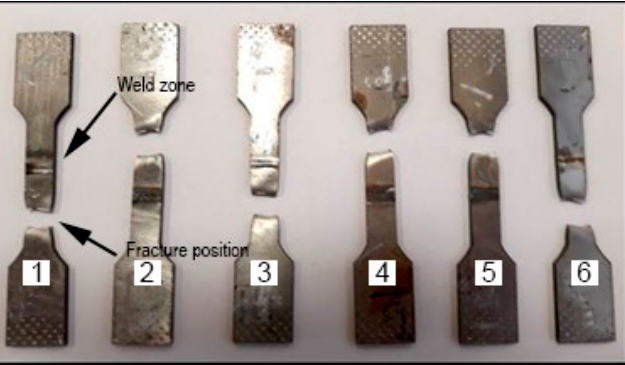
Figure 6. Tensile samples with heat inputs ranging from 1.764 kJ/mm (sample No.1) to 2.33 kJ/mm (sample No.6) after fracture, showing failure in base metal.